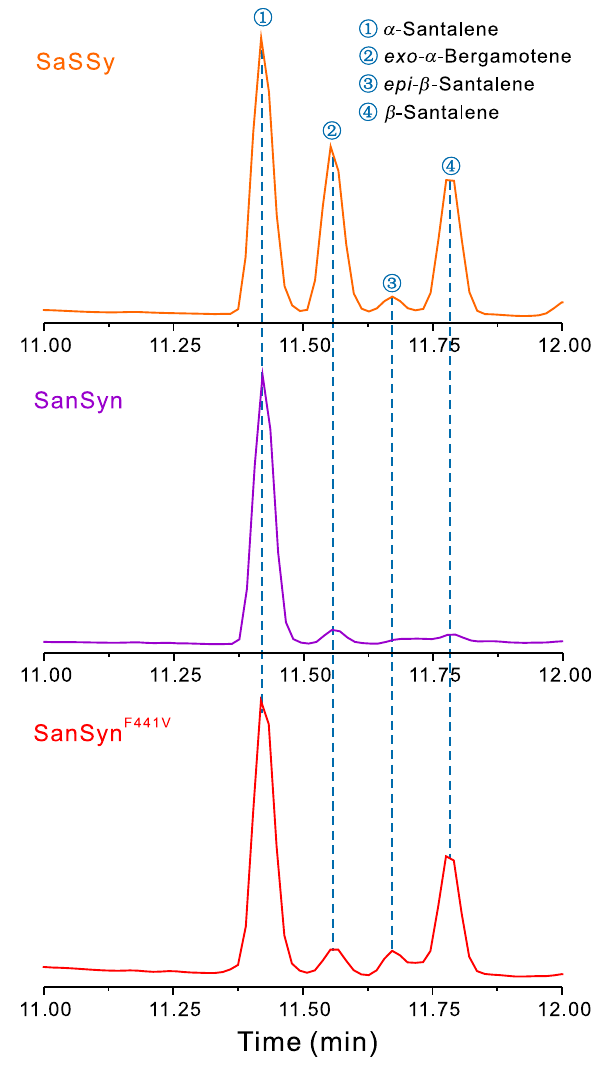
Fig. 4 GC-MS analysis of the products of SaSSy, SanSyn and SanSyn F441V . SanSyn F441V can produce both α -santalene and β